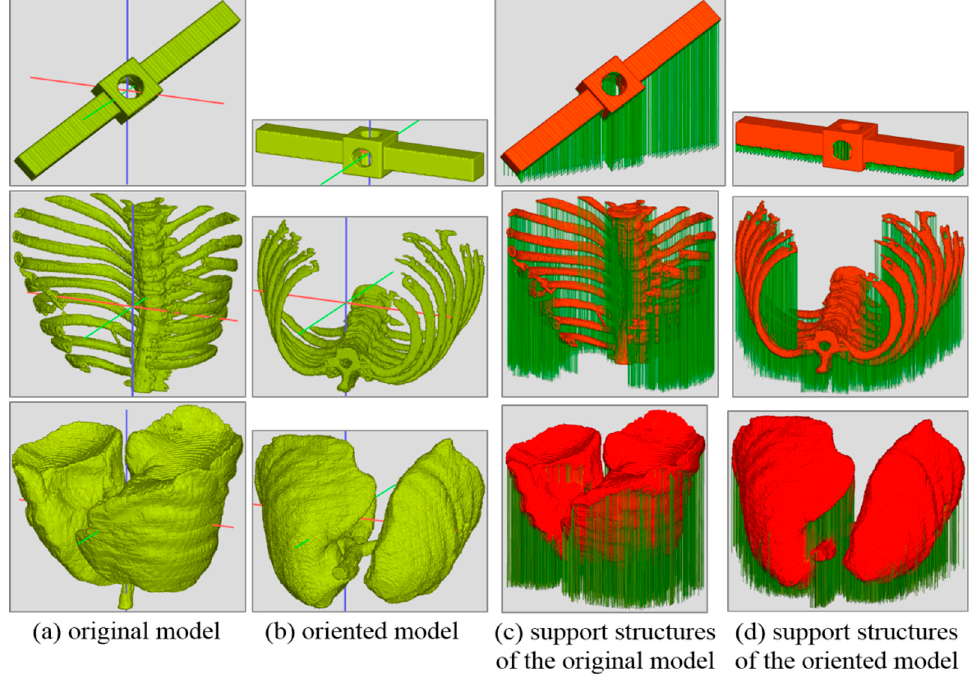
Figure 8. Images of the stick, bone, and lung models; ( a ) the raw models, ( b ) oriented models, ( c )